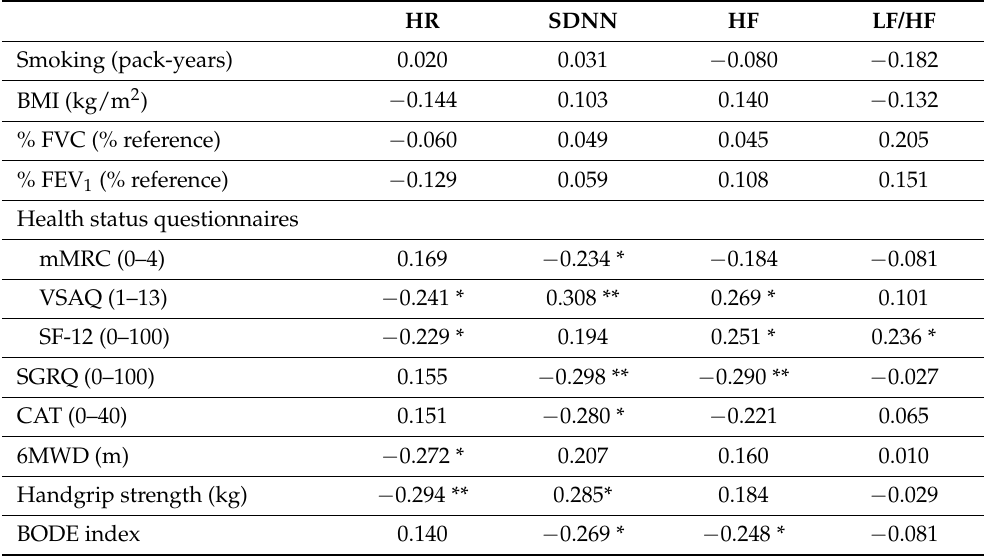
Figure 1. ( a – d ) HRV values with or without beta-agonist or muscarinic antagonist. The participants were divided into 4 groups: using concurrent beta-agonists and muscarinic antagonists (BA+ and MA+); using only beta-agonists (BA+); using only muscarinic antagonists (MA − ); and using neither class of bronchodilators (BA − and MA − ). HRV = heart rate variability; BA = beta-agonist; MA = muscarinic antagonist; SDNN = standard deviation of N-N interval; HF = high frequency; LF = low frequency. Table 3. Correlation between HRV and patient reported